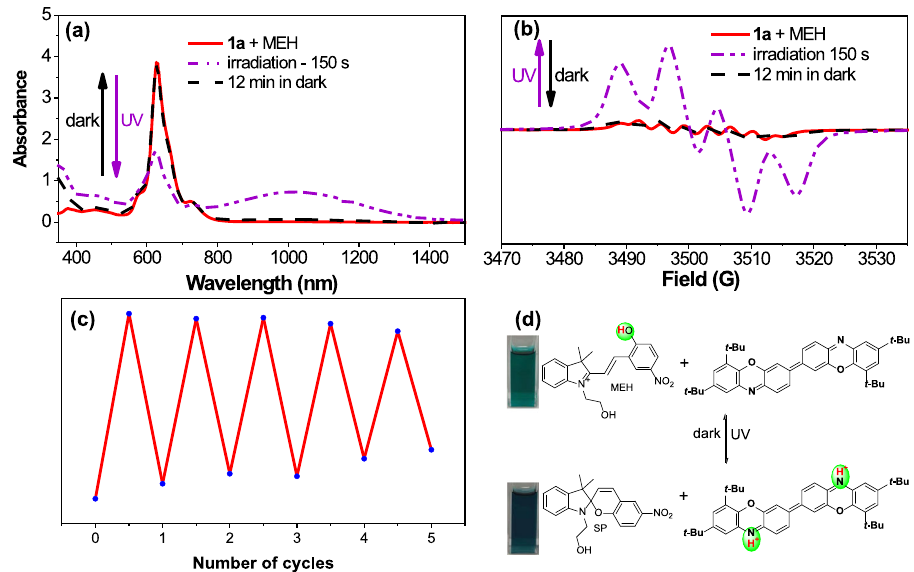
Fig. 9 Light-controlled reversible modulation of UV-vis-NIR absorption and diradical character. UV-vis-NIR absorption ( a ) and EPR spectra ( b ) of a solution of 1a and MEH (mole ratio 1a : MEH = 1: 5) before irradiation (red line), after irradiation for 150 s (purple dotted line), and kept in the dark for 12 min after irradiation (black dotted line). c The reversible changes of the absorbance under cycles of irradiation and darkness. d Schematic illustration of the light-controlled reversible protonation and deprotonation process of 1a through the use of a photoacid